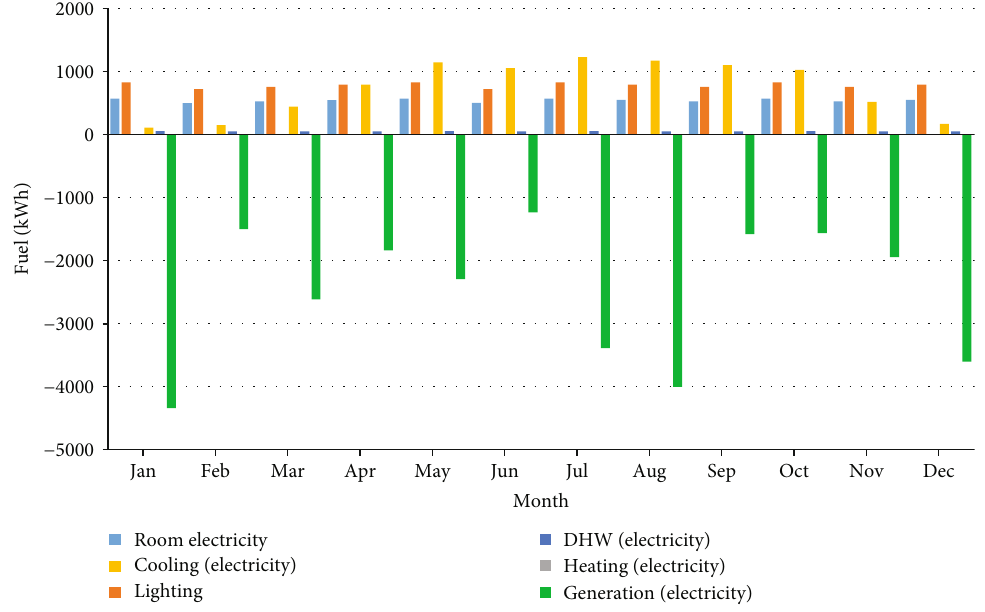
Figure 15: Monthly consumed and produced energies using renewable energies of the building within a year.